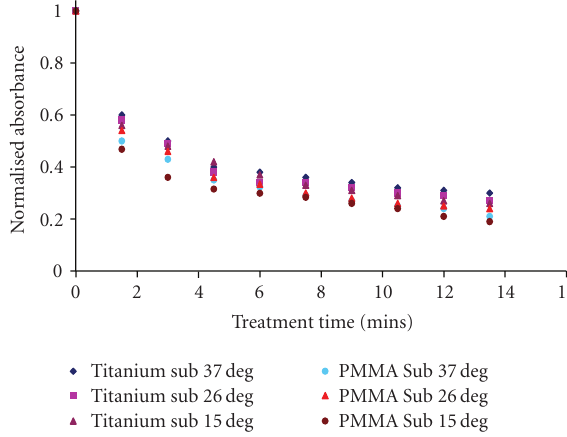
Figure 5: Comparison of TiO 2 loading and heat treatment.